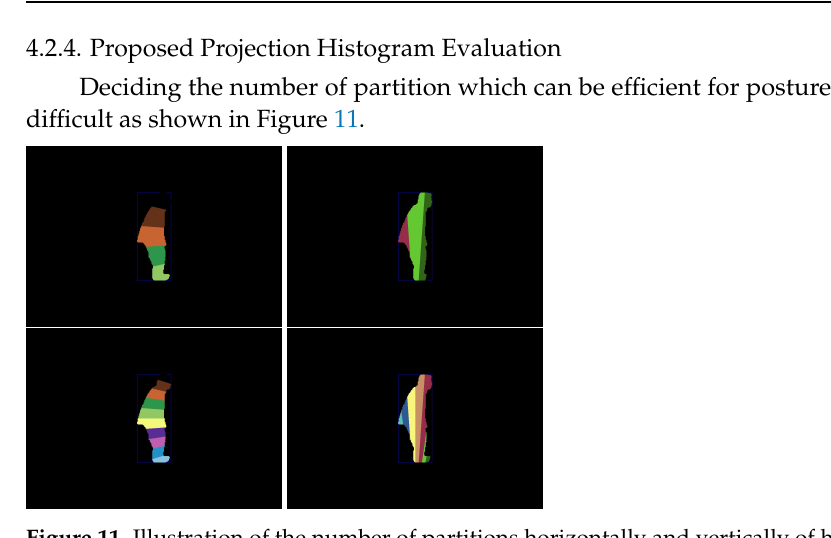
Figure 11. Illustration of the number of partitions horizontally and vertically of human shape.